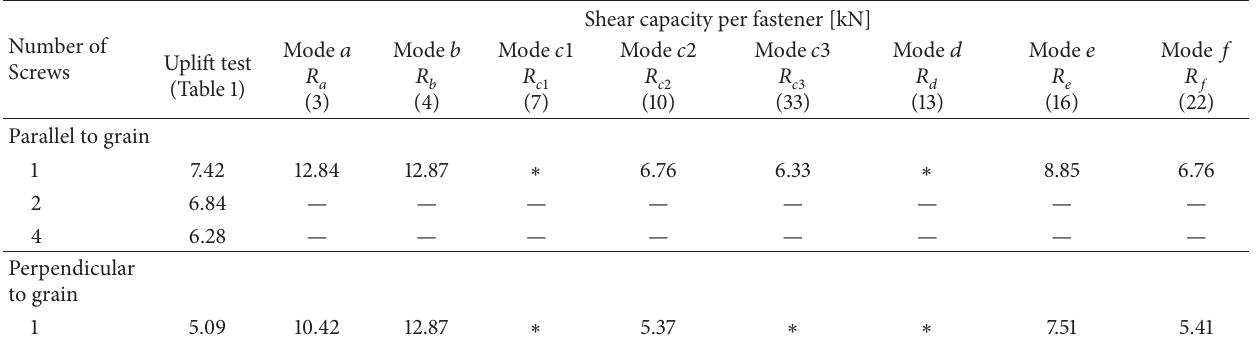
Shear capacity per fastener [kN]